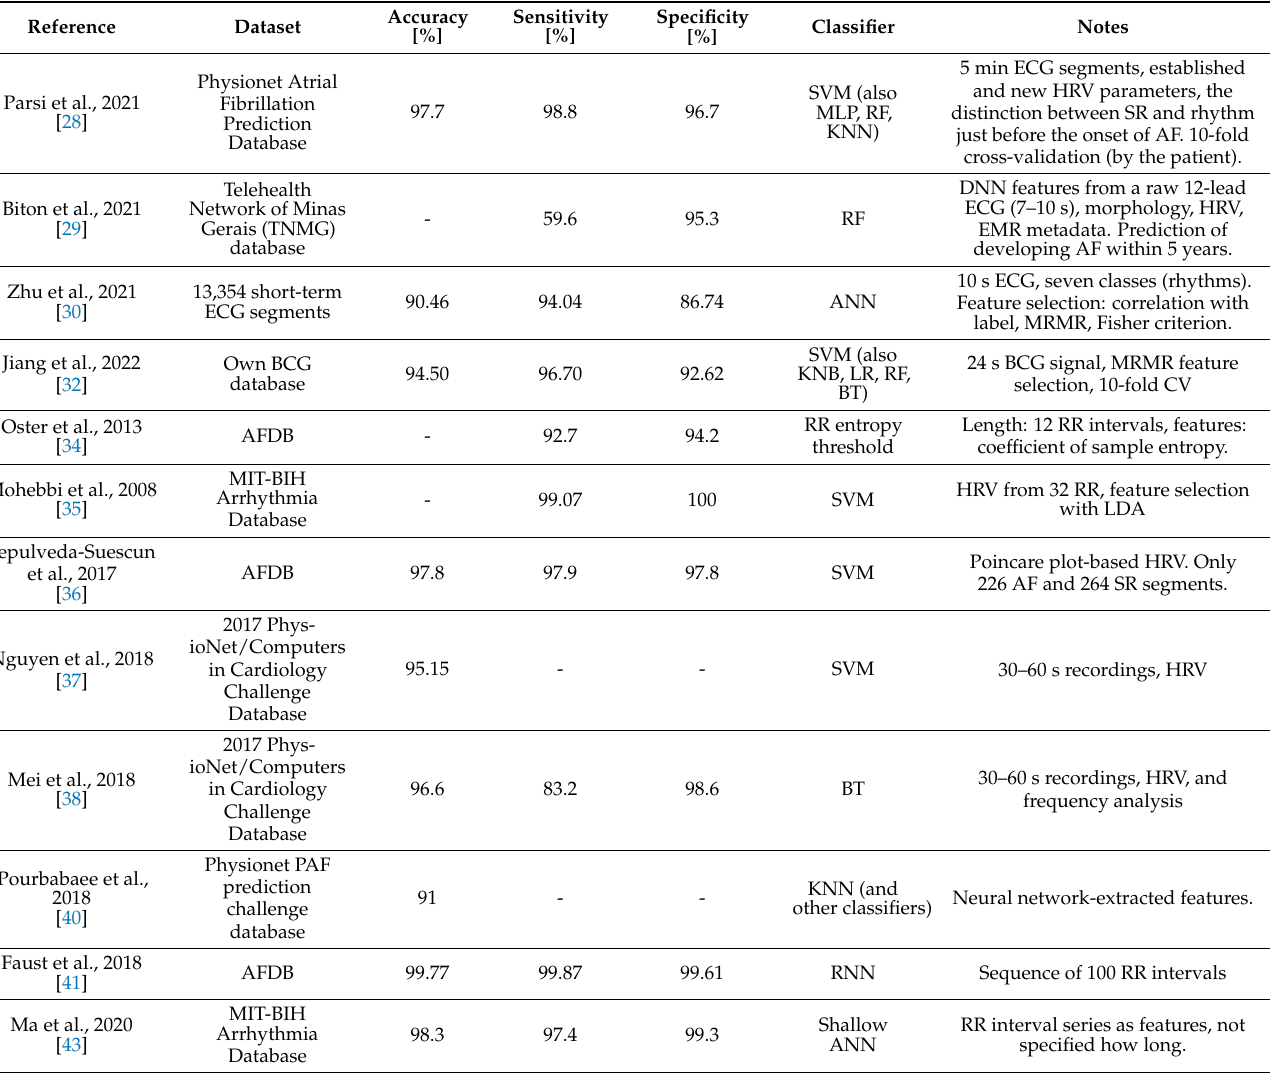
Table 1. Atrial fibrillation detection results from the